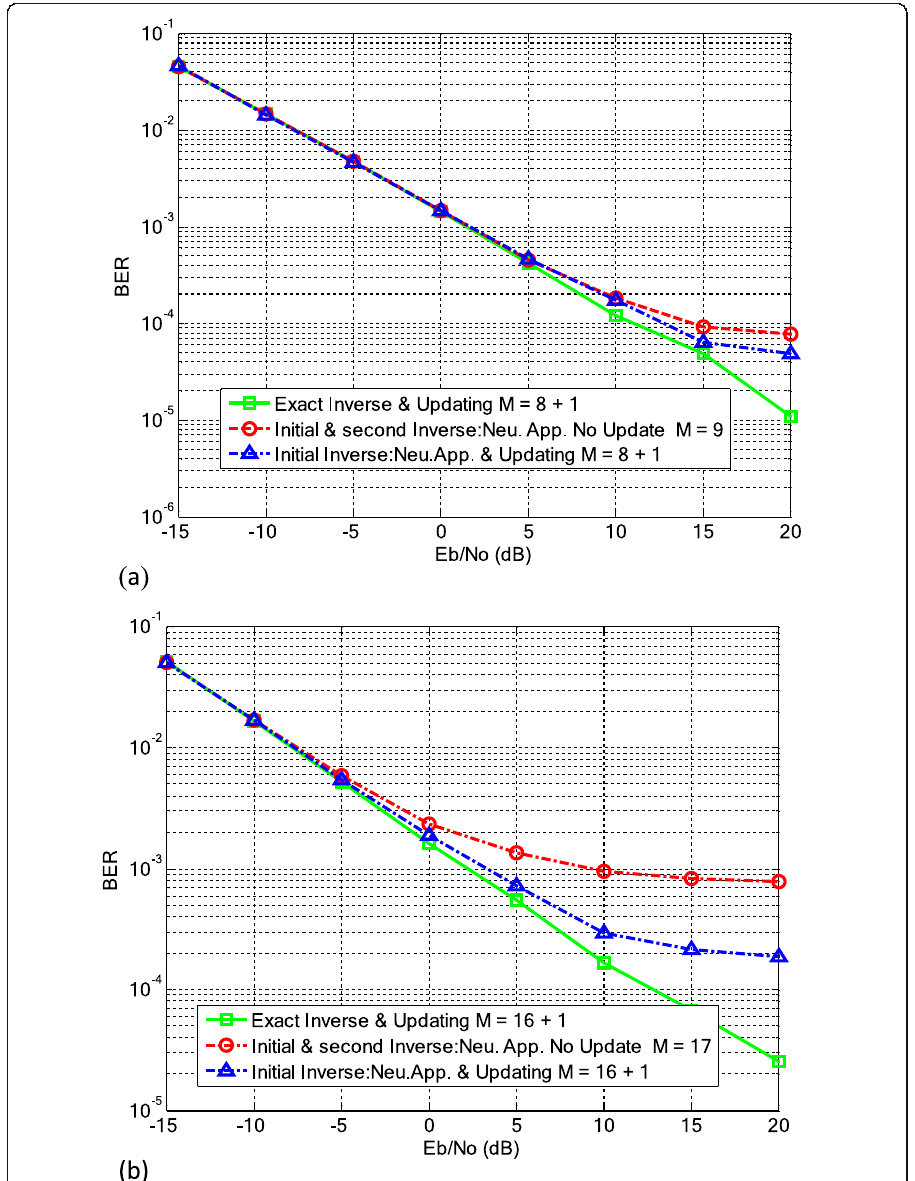
Fig. 3 BER performance comparison for inflation update and the number of current users M = 8 , 16.BS is equipped with N = 320 antennas that serves M = 8, 16 users. In the event that a user is added to the system, the proposed algorithms are used to update the inverse matrix for decoding. The results for M = 8 is shown in simulation ( a ). Simulation b demonstrates the comparison results for M = 16 after a user is added. It is observed that using Neumann series to approximate the inverse matrix will degrade the BER performance compared to the exact matrix inverse